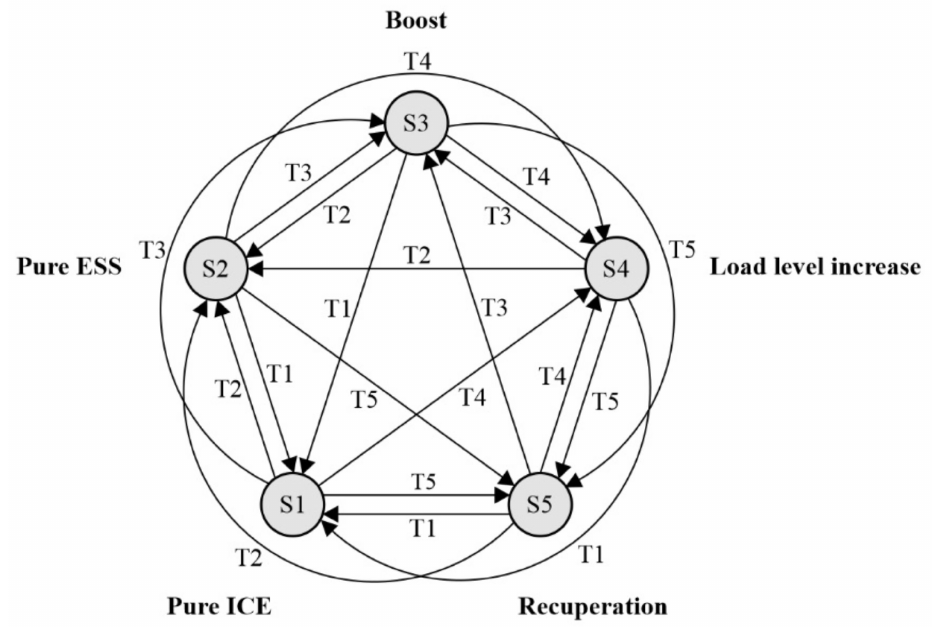
Figure 5. Finite state machine control for hybrid propulsion